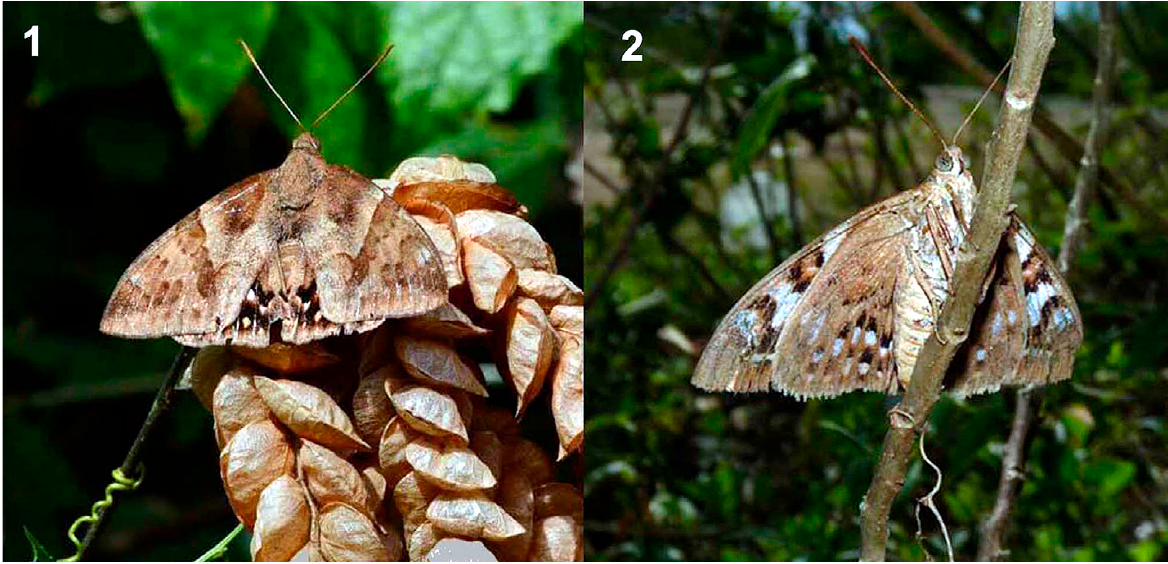
Figures 1, 2. 1. Synpalamides phalaris showing the typical stegopterous position while perched on Flemingia strobilifera (L.) W.T. Alton (Fabaceae) in a disturbed lowland forest in Innis Field, southern Trinidad. 2. Ventral view of moth perched on an unrecognized plant stem in the dry semi-seasonal forest of L’eau Michele, Southern Watershed Reserve, southern Trinidad. (Photographs: K.